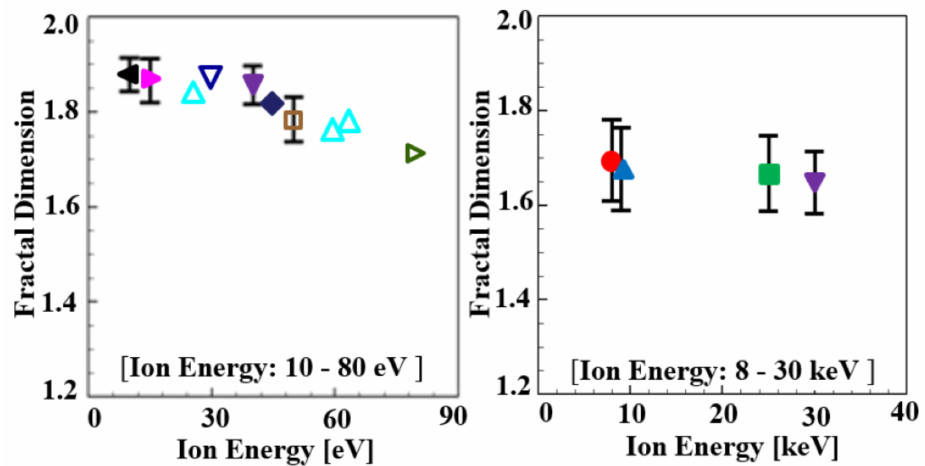
Figure 1. Fractal dimension of irradiated W microstructures as a function of He/D irradiation ion energy: ( a ) Low ion energy (10–80 eV); ( b ) high ion energy (8–30 keV). Details on irradiation conditions and the references are listed in Table